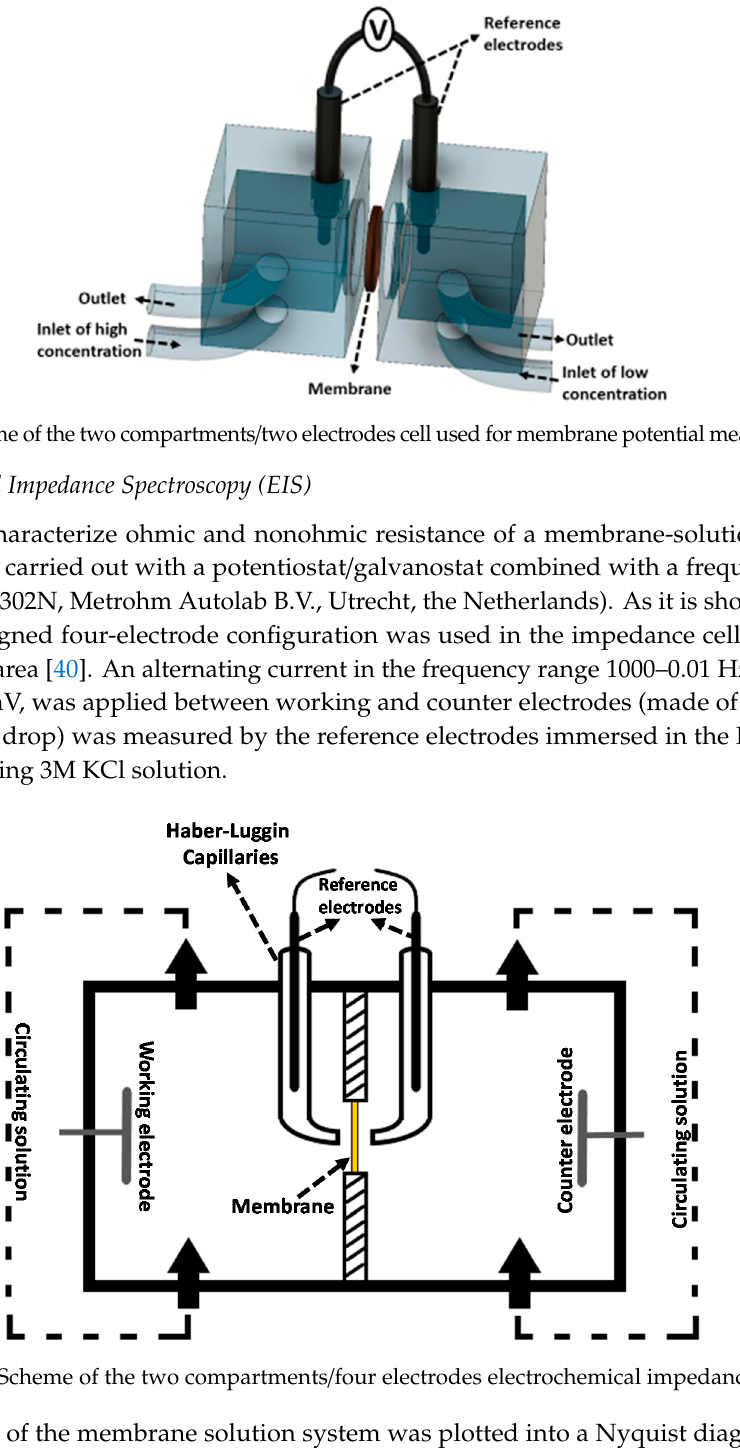
Figure 5. Scheme of the two compartments/four electrodes electrochemical impedance cell.